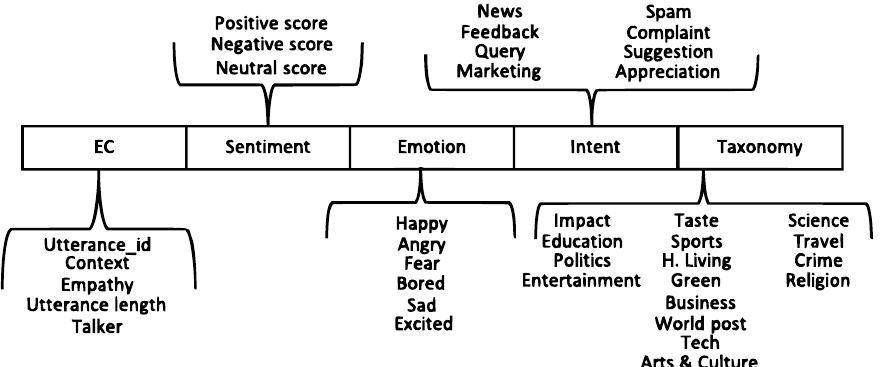
Figure 5. Representation of a text utterance.